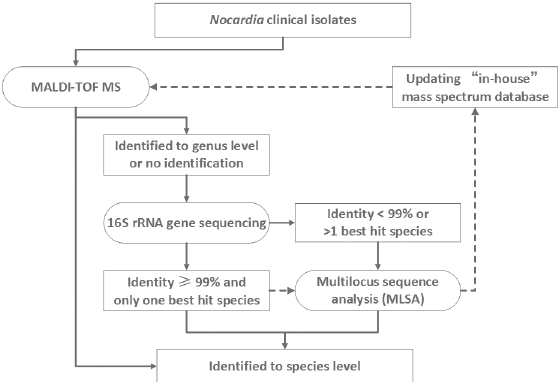
Fig 3. Proposed algorithm for laboratory identification of Nocardia isolates (solid lines) and establishment and expansion of ongoing “ in-house ” mass spectrum database (dashed lines).